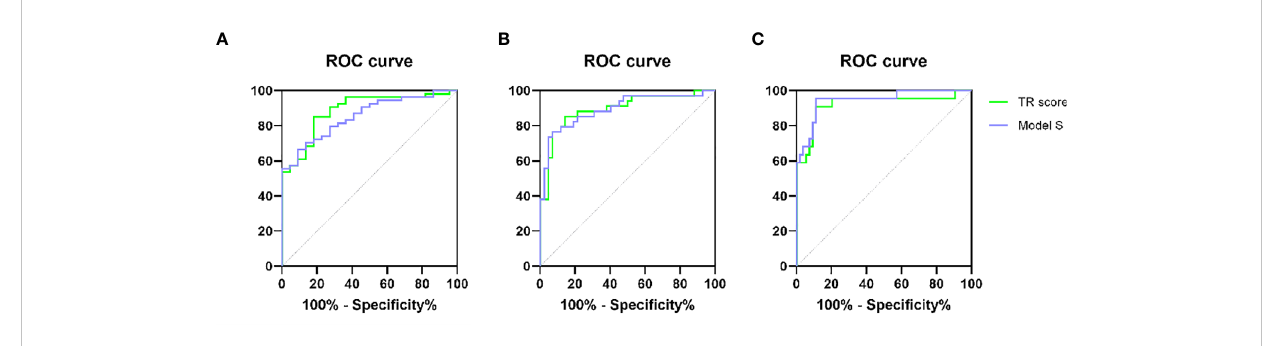
FIGURE 2 ROC generated by TR score and Model S for prediction of S2-S4 (A) , S3-S4 (B) and S4 (C) .